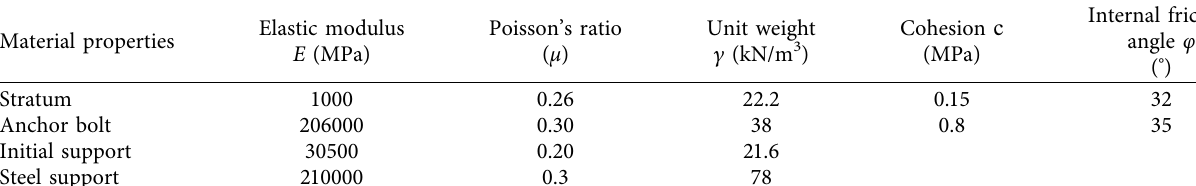
Table 1: Physical and mechanical parameters.